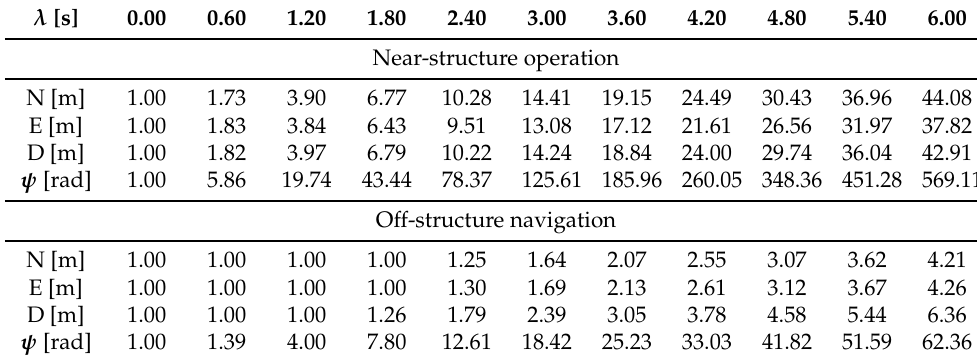
Figure 14. (cid:107) S (cid:107) ∞ , min for off-structure navigation with upper and lower control bound. Table 9. Selected values for (cid:107) S (cid:107) ∞ , min